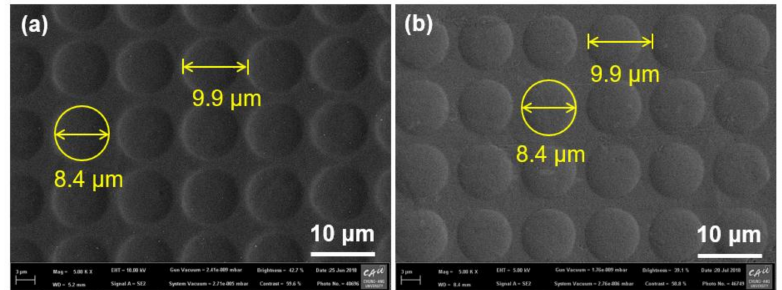
Figure 2. Scanning electron microscope (SEM) images of ( a ) microdome cavities on GC mold and ( b ) microdome array on aluminum (Al) substrate fabricated by DMF with a temperature of 645 ◦ C and a pressure of 2 MPa.